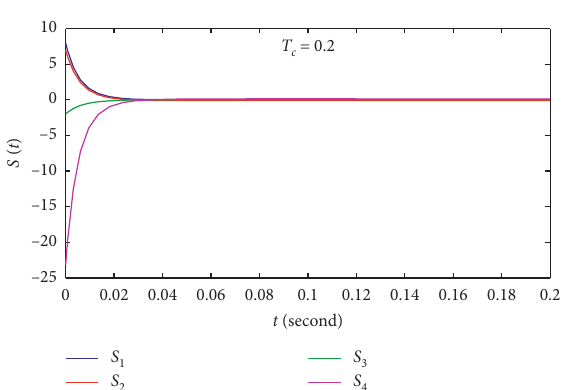
Figure 9: Time response of sliding mode surface switching function S ( t ) with T c � 0 . 2.